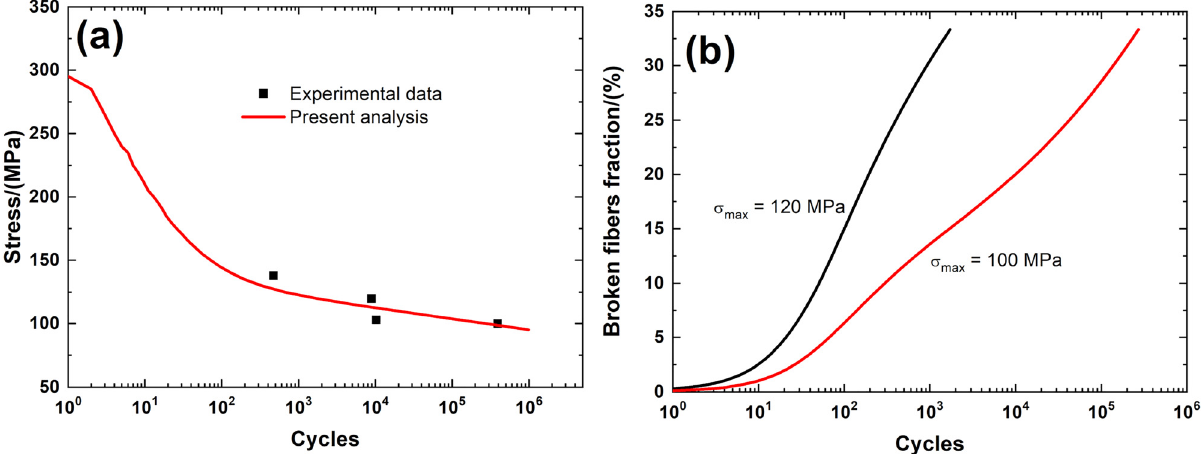
Figure 9: ( a ) Experimental and predicted fatigue life S – N curves, and ( b ) the FBFF versus applied cycles of cross - ply SiC/MAS composite under IF loading at 566°C in air